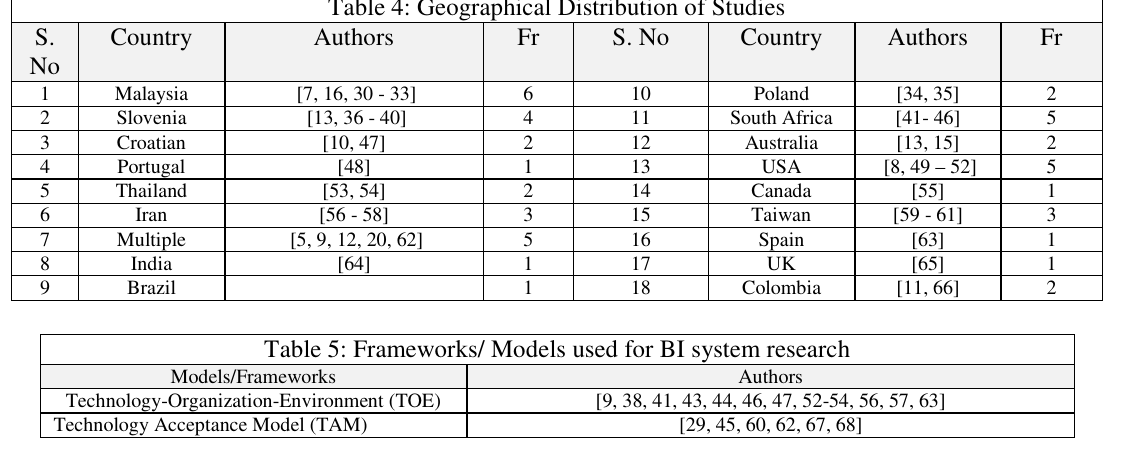
Table 4: Geographical Distribution of Studies